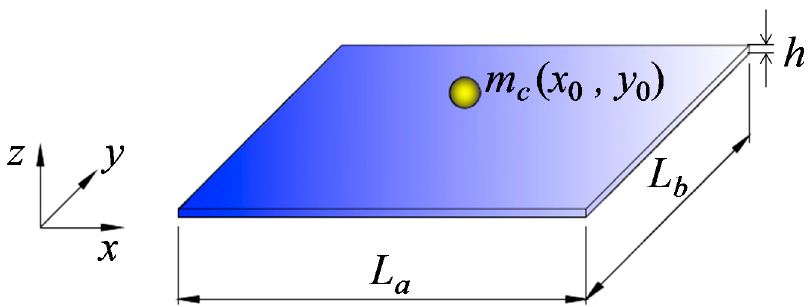
Figure 1. Schematic illustration showing graphene sheet with an attached mass.